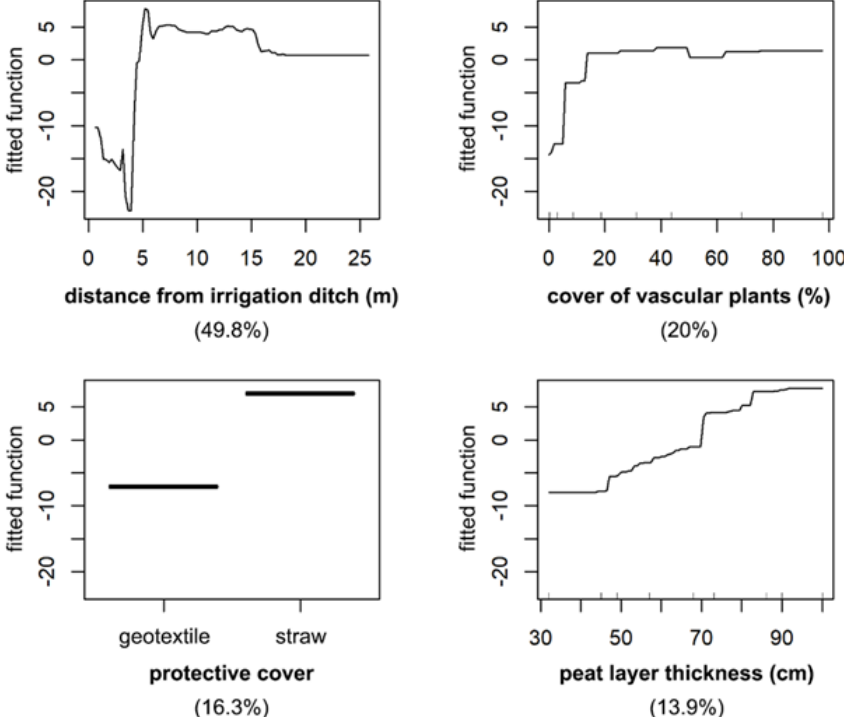
Figure 8. Boosted regression tree partial dependence plot showing the effect of the four most influential predictor variables on the establishment of Sphagnum at the two study sites Drenth (126 observations) and Provinzialmoor (121 observations) expressed as cover (%) with the predictor variables being distance from irrigation ditch (m), cover of vascular plants (%), cover of Eriophorum angustifolium (%), type of protective cover (straw & geotextile) and peat layer thickness (cm). The fitted function is the difference between the actual y-axis value and the mean response value. The important predictor range is where the fitted function is above zero. The graphs show the effect of a particular variable on the response: positive fitted function values suggest that Sphagnum cover responds favourably and low values suggest the opposite. The relative influence for each predictor variable is shown in parentheses below each